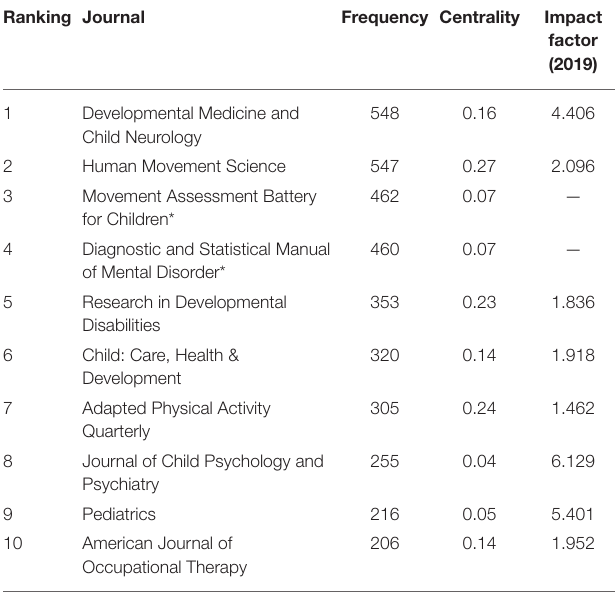
TABLE 6 | Top 10 highly cited journals in research of children with DCD,